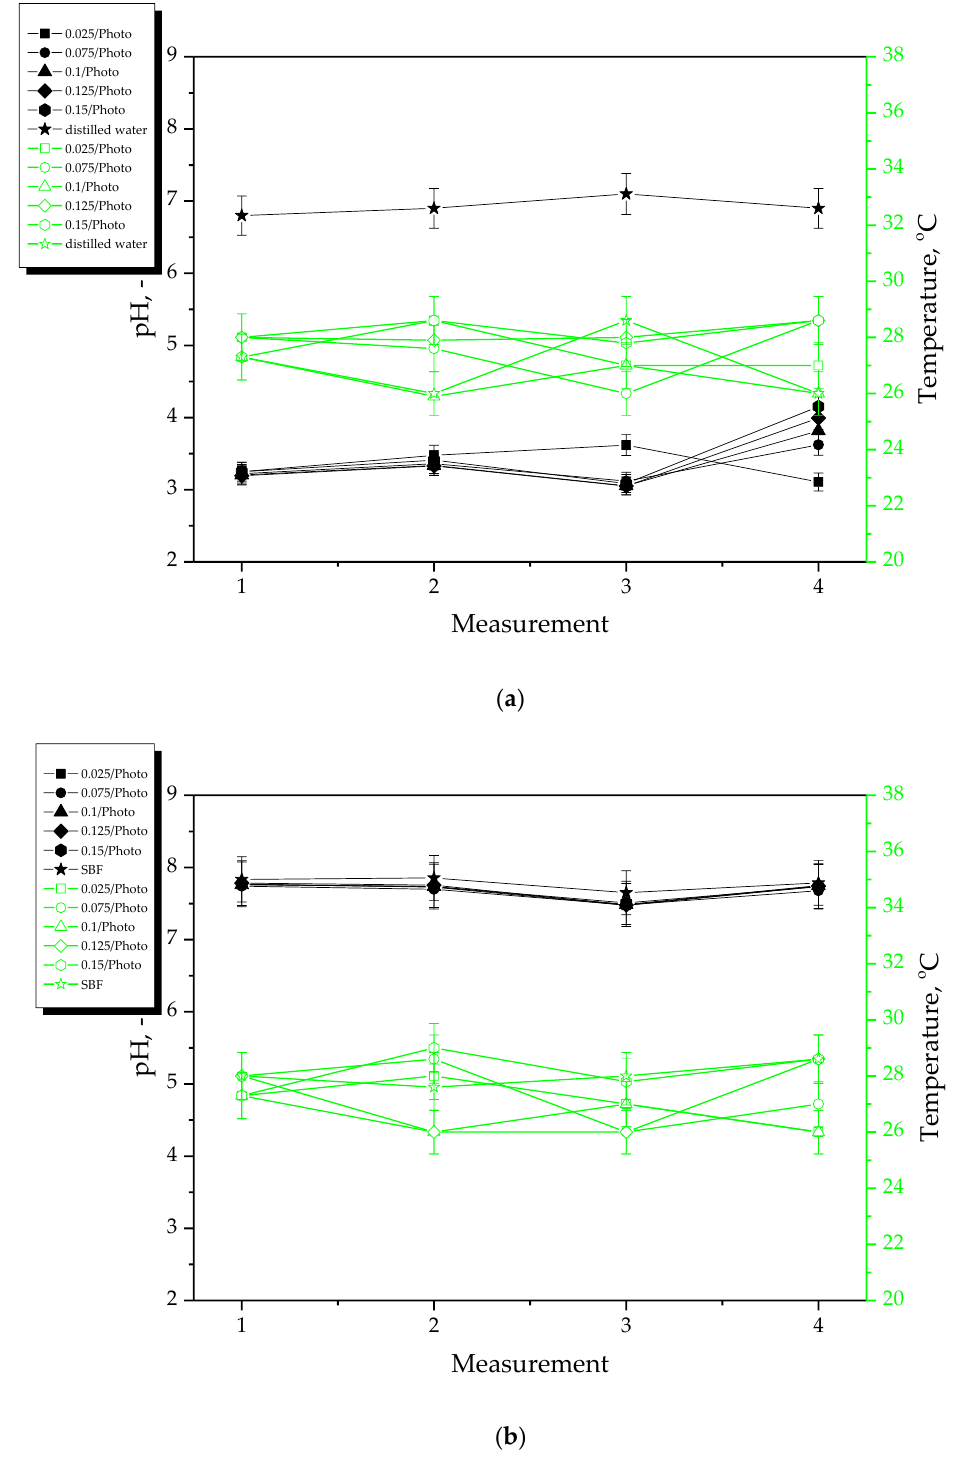
Figure 2. Results of incubation of hydrogels in distilled water ( a ) and SBF ( b ).